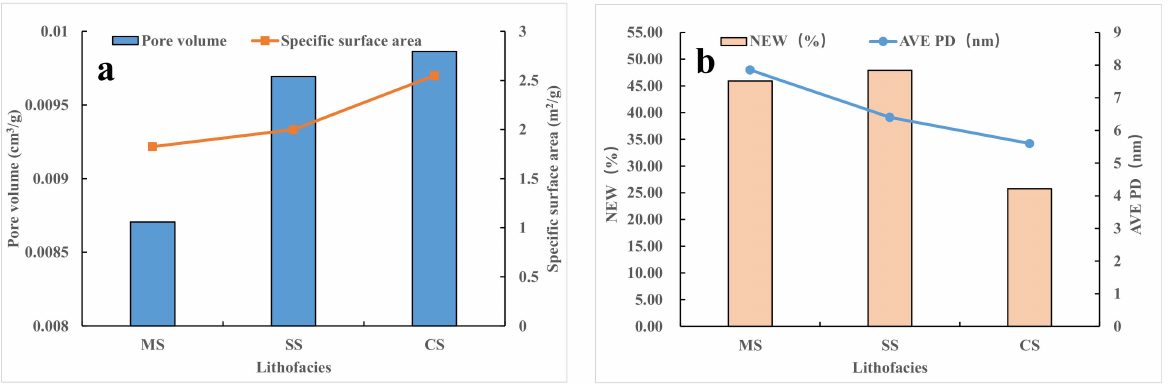
Figure 12. Distribution of mean values of pore structure parameters for different lithofacies: ( a ) mean values of PV and SSA for different lithofacies; ( b ) mean values of MWE and AVE PD for differ- ent